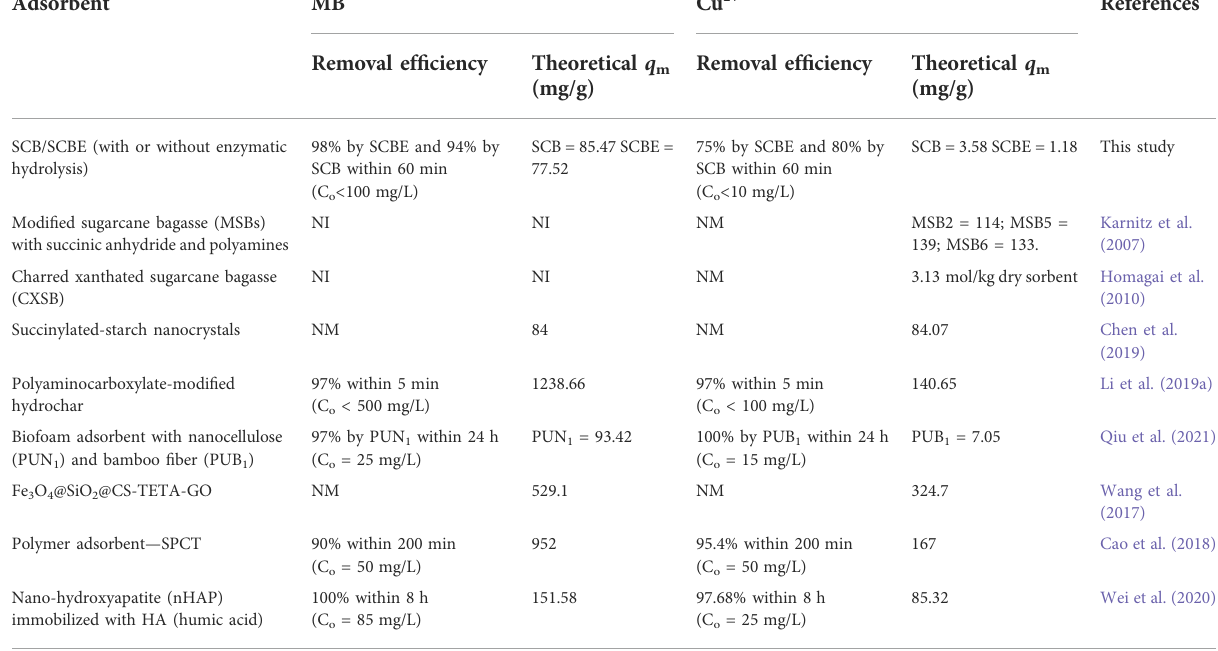
TABLE 3 Comparison of MB dye and Cu 2+ adsorption by SCB/SCBE and by some representatives of modi fi ed/synthesized adsorbents reported in the recent literature.